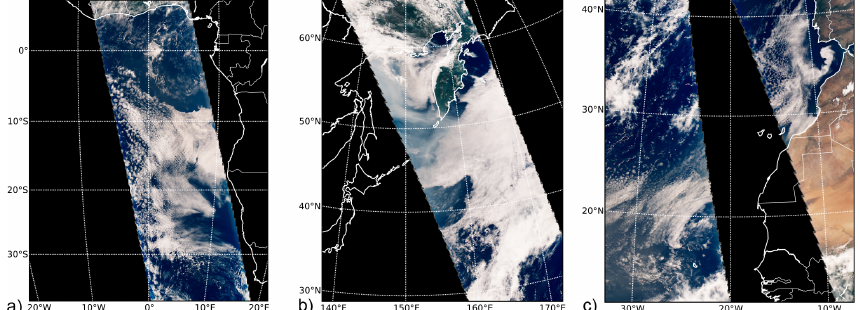
Figure 6. True color POLDER/PARASOL RGB composite (a) over the southeast Atlantic Ocean on 4 August 2008, (b) off the east coast of Russian on 3 July 2008 and (c) over the North Atlantic Ocean on 4 August 2008.